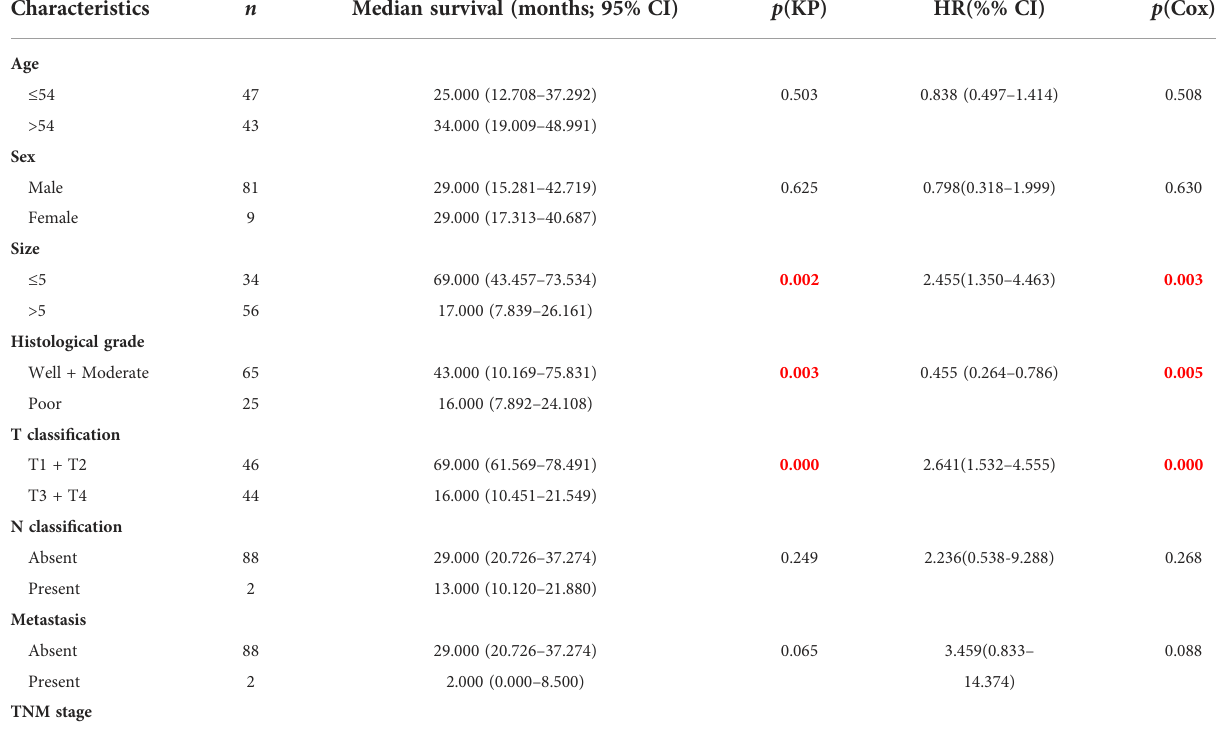
TABLE 2 Univariate analysis of survival in patients with hepatocellular carcinoma (HCC) by Kaplan – Meier survival analysis and Cox regression analysis.